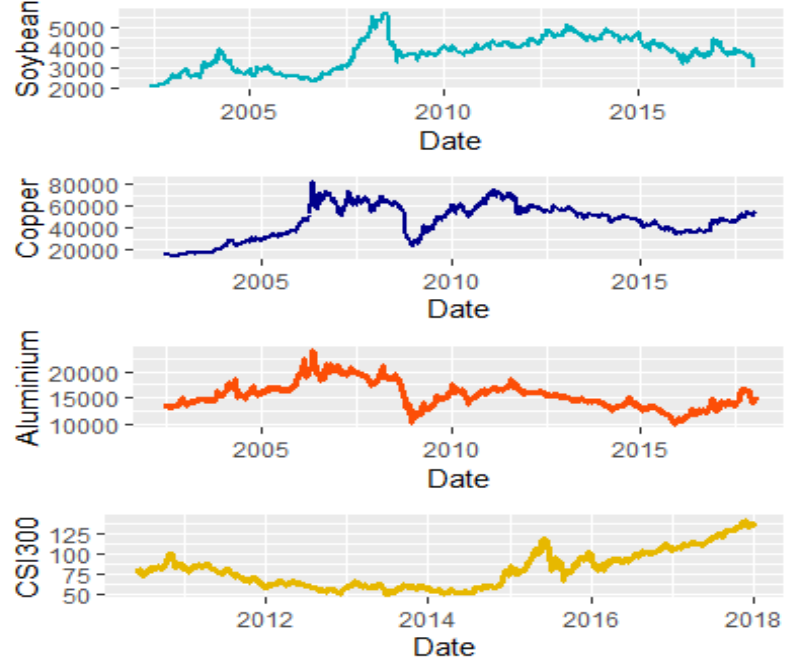
Figure 1. The price of the futures contract.